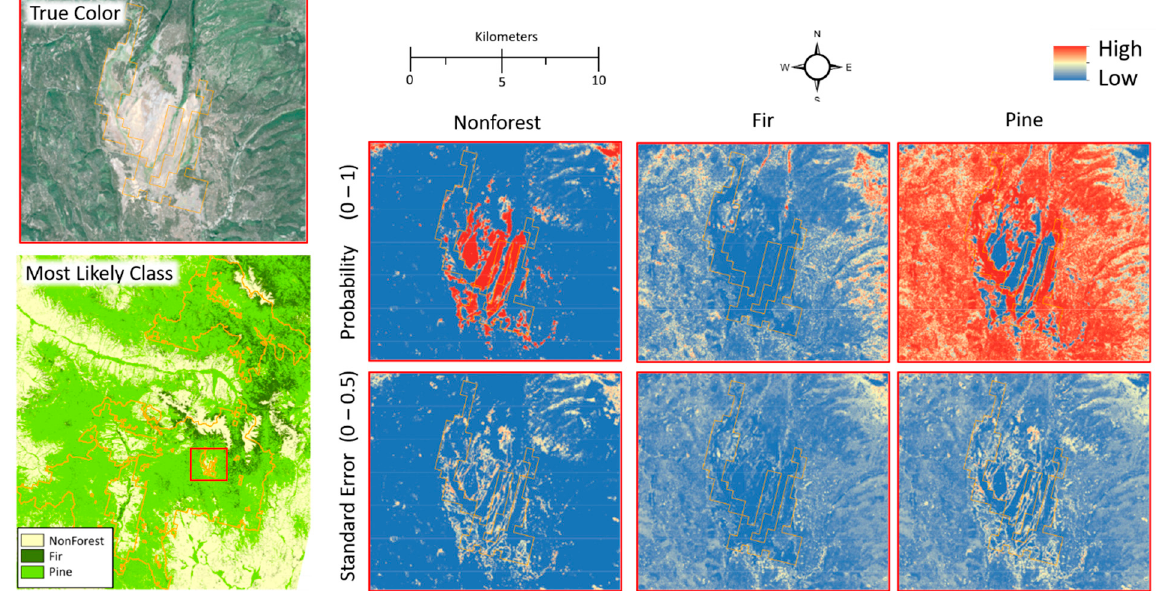
Figure 5. Zoomed-in region (red box) of raster surface depicting the spatial distribution of DomType class probability, standard errors, and the most likely class (MLC). The MLC cell value was determined by the largest cell probability for a given class. The range of color ramp values for class probabilities and standard errors is displayed within the parentheses of each graphic label. A True Color sentinel 2 image composite of the zoomed-in area is provided for reference and comparison.